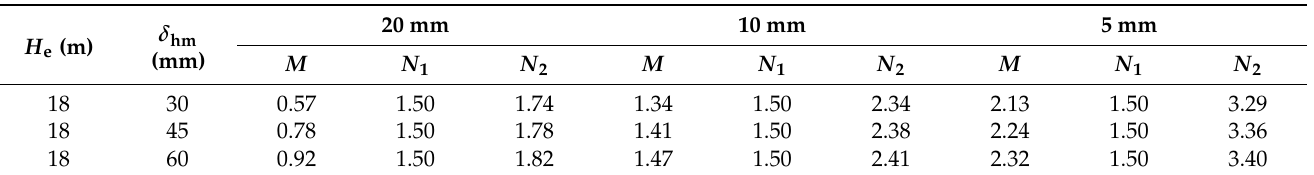
Table 5. Determination parameters of the influenced zones of deep excavation obtained by the proposed